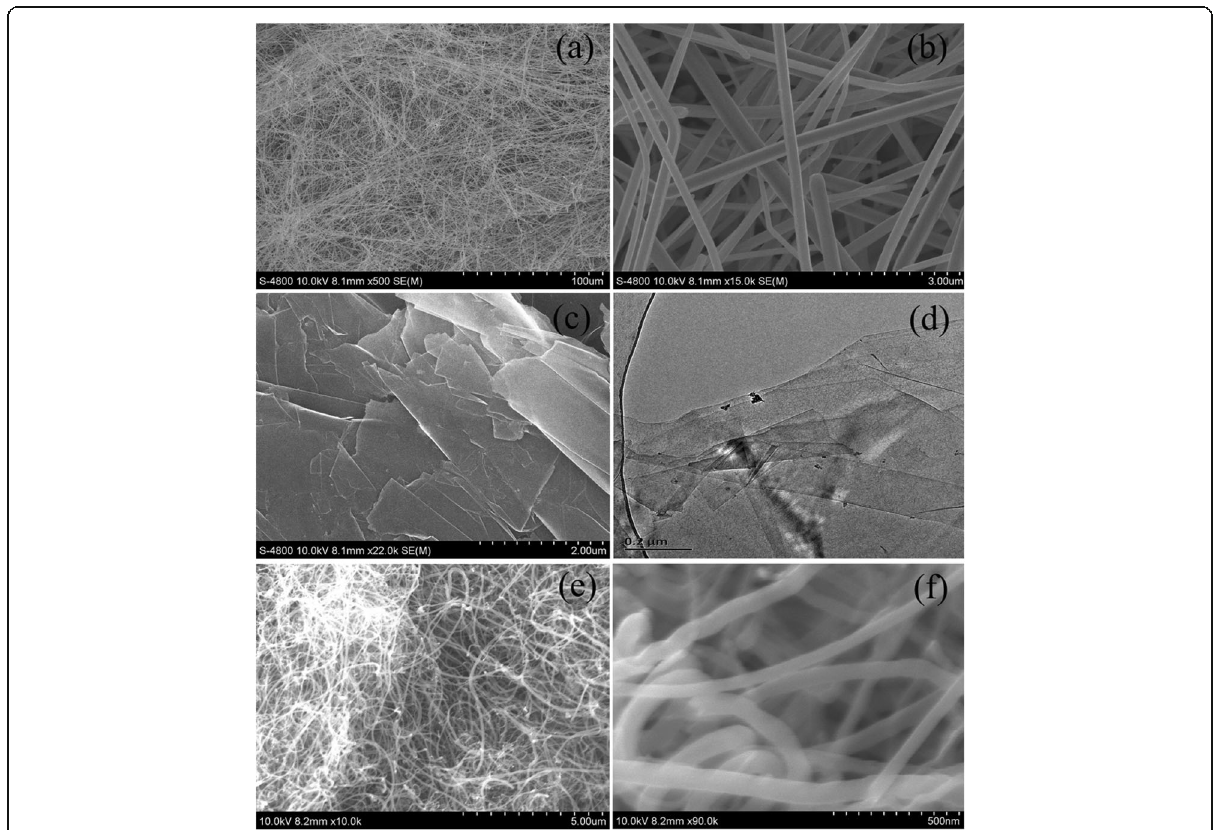
Fig. 1 FE-SEM images of different samples of a CuNWs, c GNPs, and e MWCNTs at low magnification and of b CuNWs and f MWCNTs at high magnification. TEM image of ( d ) GNPs